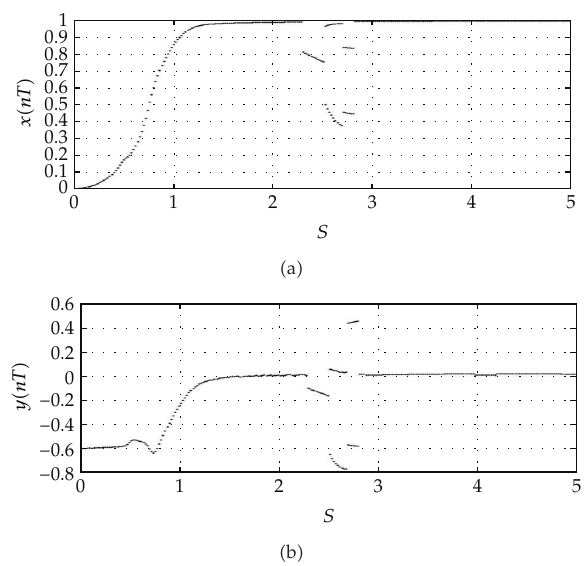
Figure 3: Bifurcation diagram of X (cid:2) nT (cid:3) (cid:2) a (cid:3) and Y (cid:2) nT (cid:3) (cid:2) b (cid:3) versus rotor speed s (cid:2) without rub-impact e ff ect (cid:3) .